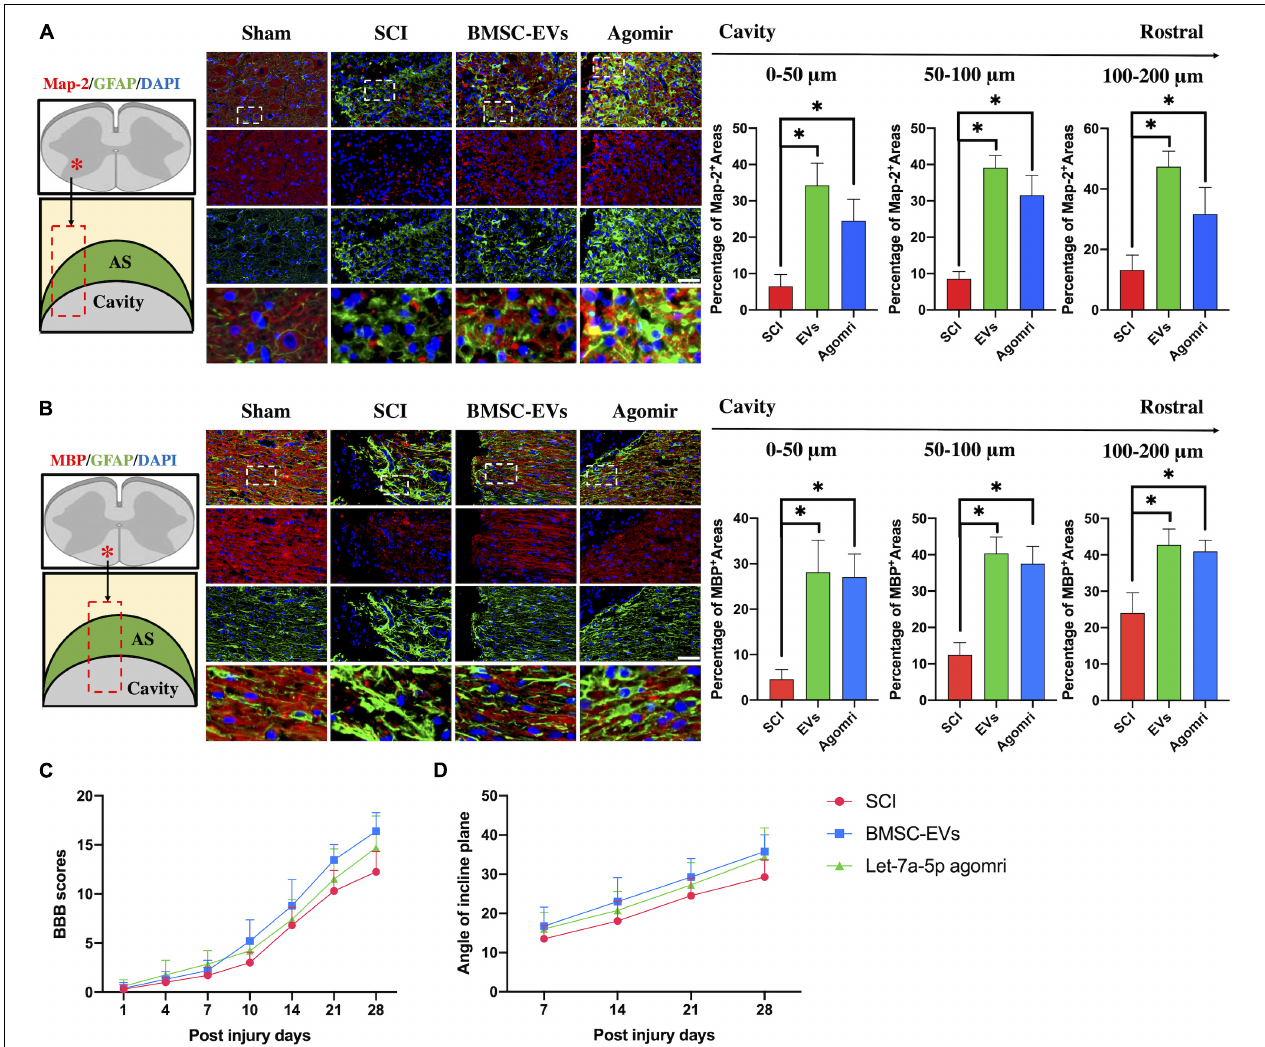
FIGURE 2 | BMSC-EVs and let-7a-5p agomirs promoted the regeneration of neurons and their outgrowth in the glial scar surrounding the cavity, resulting in a better neurological outcome compared with the SCI rats. (A,B) In SCI rats, an astrocytic scar boundary was formed around the cavity, and Map-2 and MBP positive neurons were seldom present within the astrocytic scar. In contrast, the rats that received either BMSC-EVS or let-7a-5p agomir treatment had a significantly increased amounts of Map-2 and MBP positive neurons in the glial scars around the cavity ( n = 5; data are mean ± S.D; Student’s t- test was used for comparisons. ∗ p < 0.05; scar bar, 50 µ m). (C,D) BBB scores and incline plane test showed that the neurological outcomes were improved in rats that received either BMSC-EVs or let-7a-5p agomirs compared with SCI rats ( n = 10; data shown as mean ± S.D). (The term BMSC-EVs is abbreviated as EVs and let-7a-5p agomir is abbreviated as